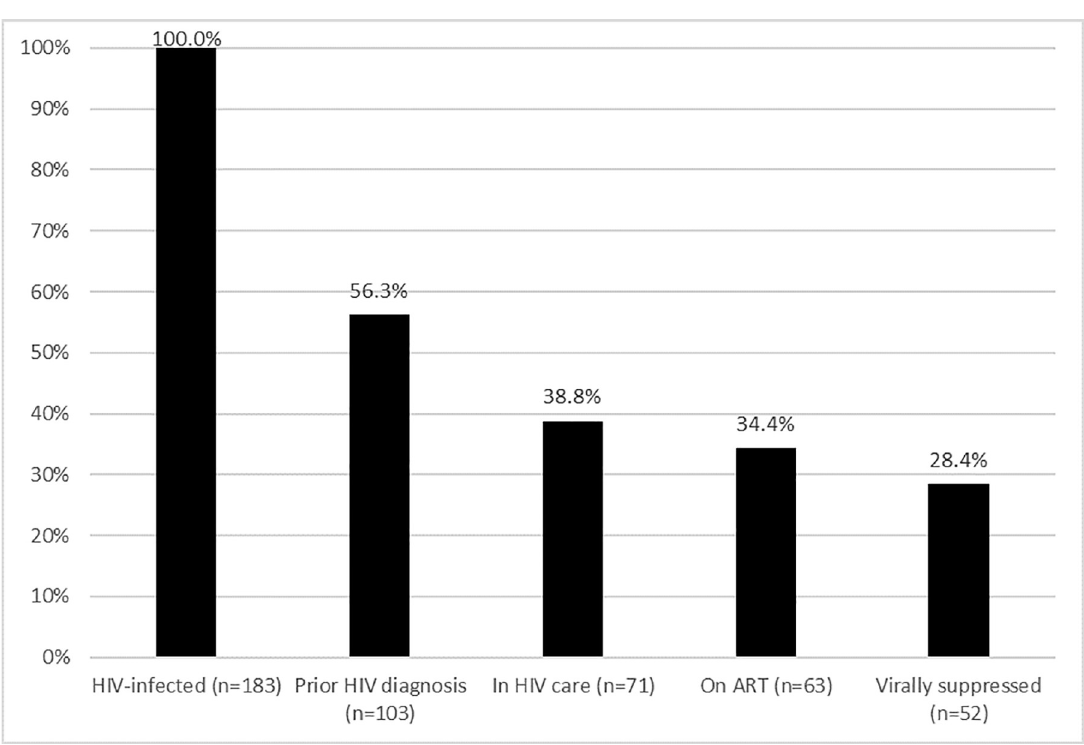
Fig 1. HIV care continuum for HIV-infected persons screened for participation in HPTN